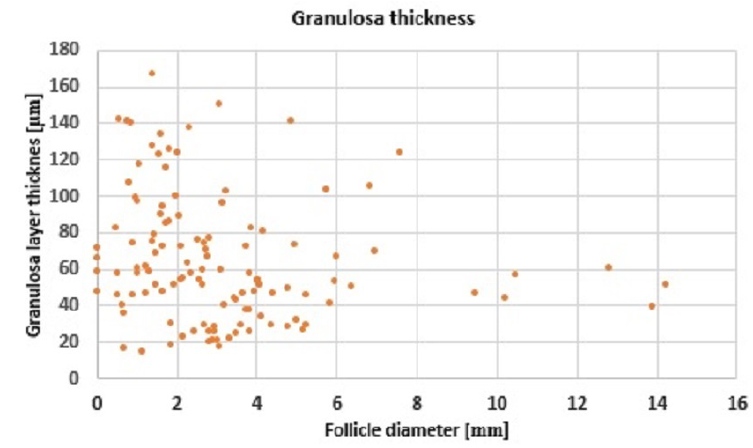
Figure 3. Granulosa thickness at different diameters of the follicle.